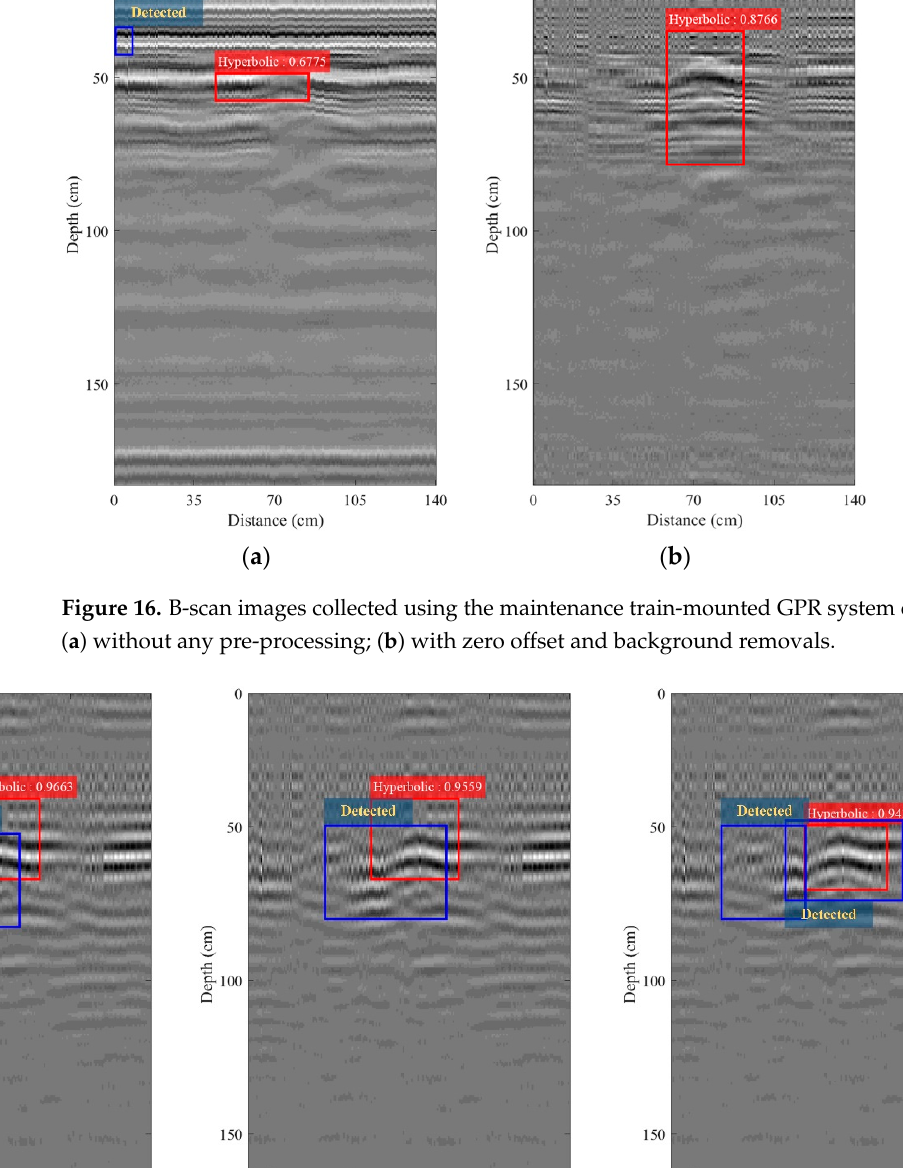
( b ) Figure 18. B-scan images collected using the maintenance train-mounted GPR system on the railway and obtained from performing the time-varying gain: ( a ) k = 0.05; ( b ) k = 0.1. Table 3. Performance of the detection of the proposed GPR system. Without Any Pre-Processing